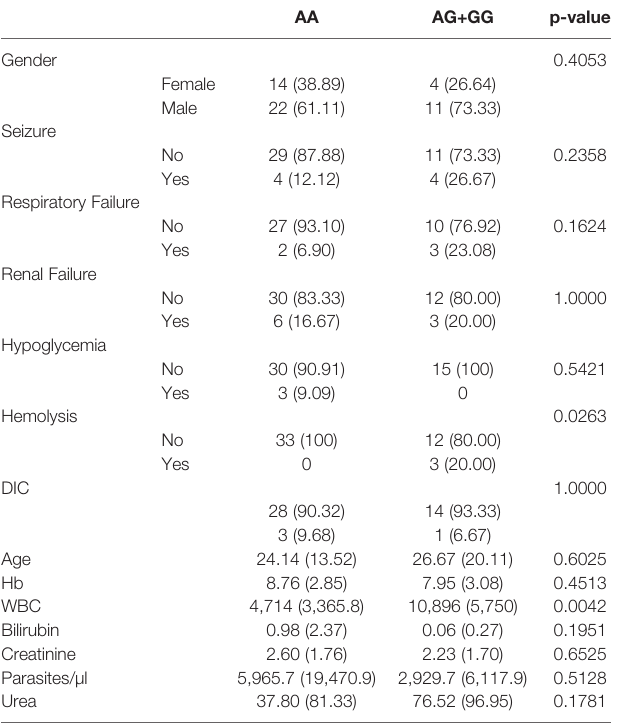
TABLE 3 | The ratio of rs867186 genotype-AA versus -AG and – GG in HC, MM, and CM. AG+GG